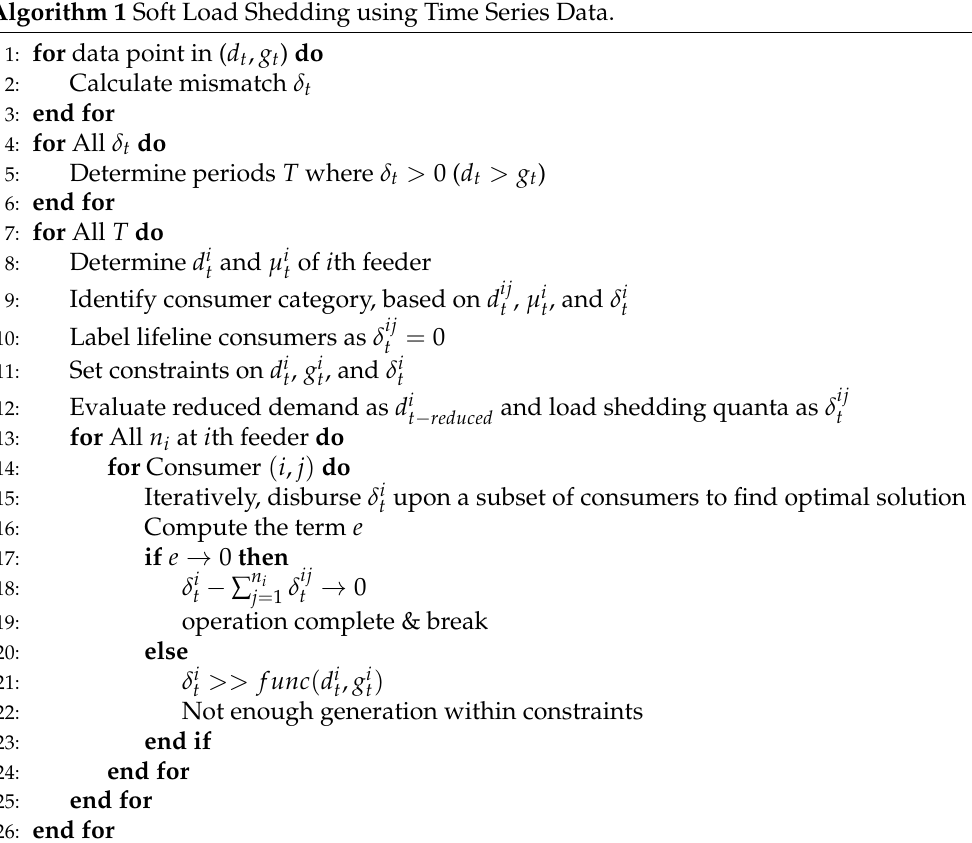
Algorithm 1 Soft Load Shedding using Time Series